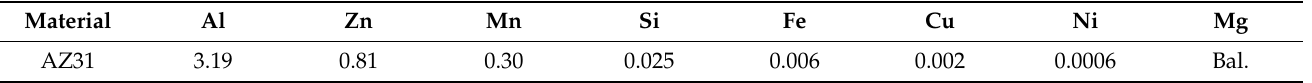
Table 1. The nominal chemical composition of AZ31 magnesium alloys (wt.